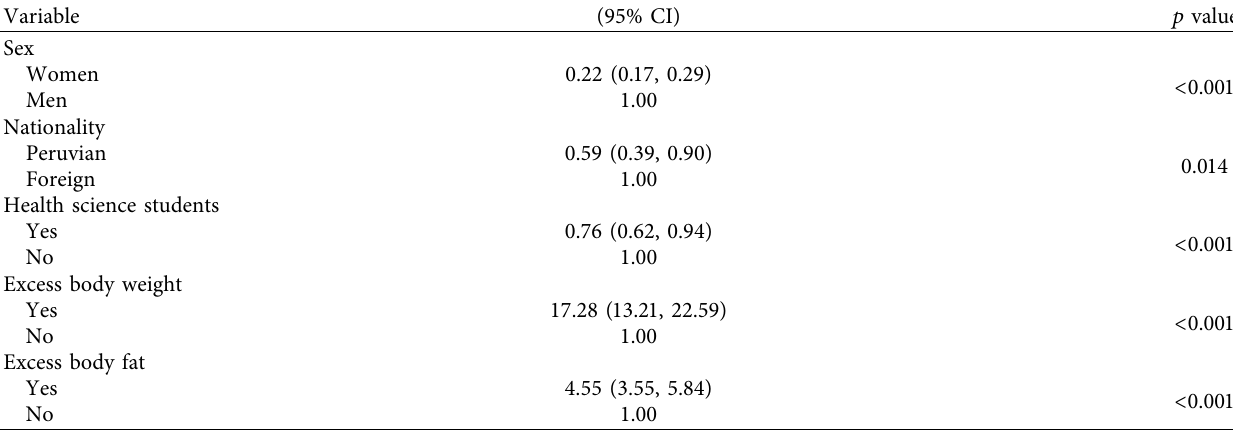
Table 2: Odds ratio for CMR in university